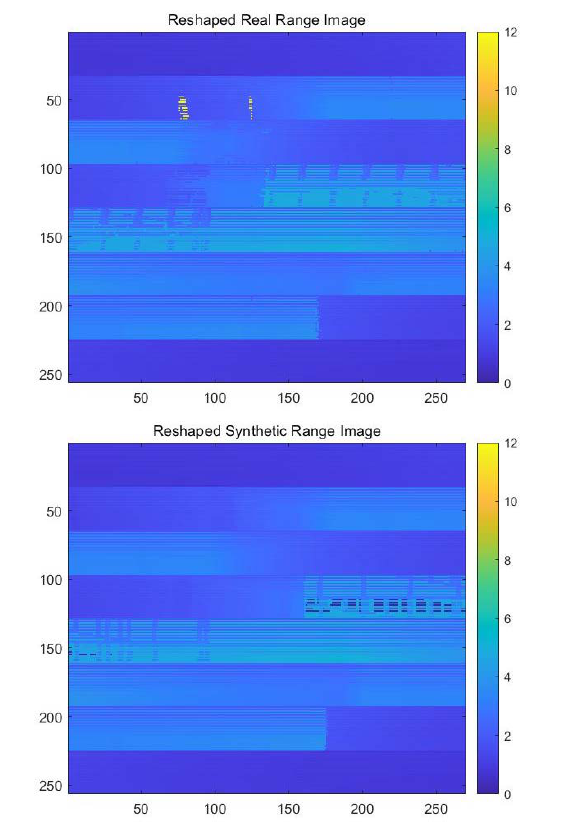
Figure 8. Reshaped real range image and synthetic range